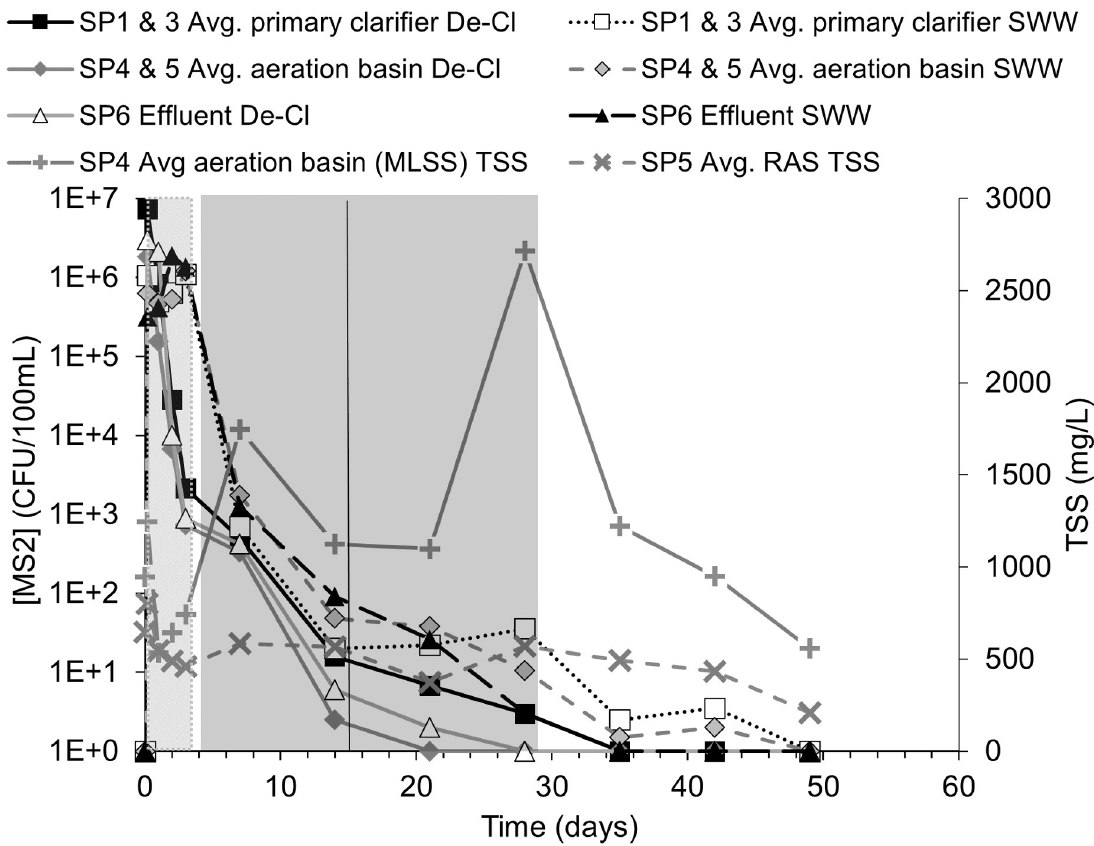
Fig 6. Averaged MS2 concentrations and TSS in the RAS and aeration basin effluent. De-Cl = “dechlorinated water” and SWW = “synthetic wastewater.” The light gray block shows the possible HRT range of 0.375 to 3.375 days. The black vertical line is the average calculated SRT of 15.0 ± 10.9 days and the darker gray bar represents the SRT possible range of 4.1–28.9 days, respectively. SP1 and SP3 were averaged for “average primary clarifier” series. SP4 and SP5 were averaged for “average aeration basin” series. The “+” and “x” series show the TSS in the aeration basin effluent and RAS, respectfully. Error bars were removed for visual clarity. Original data in S2